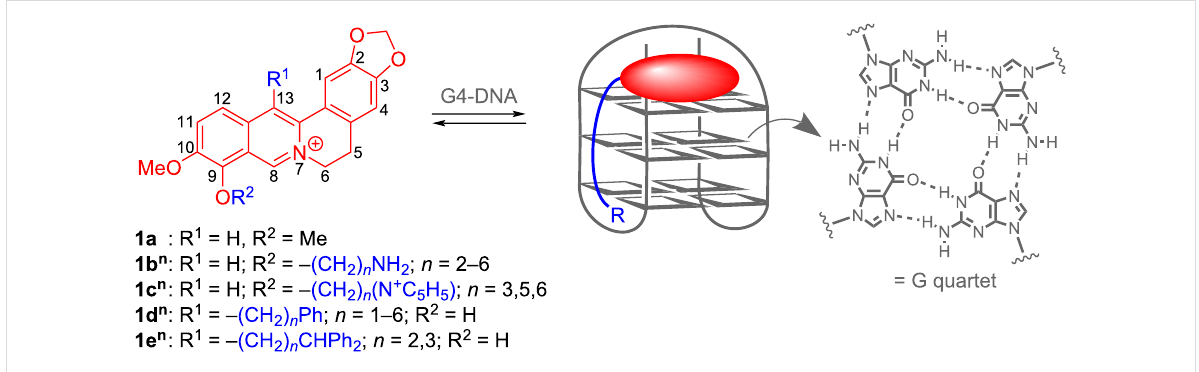
Scheme 1: The structures and numbering of berberine ( 1a ) and the alkyl-substituted derivatives 1a n – e n and the binding equilibrium with quadruplex DNA